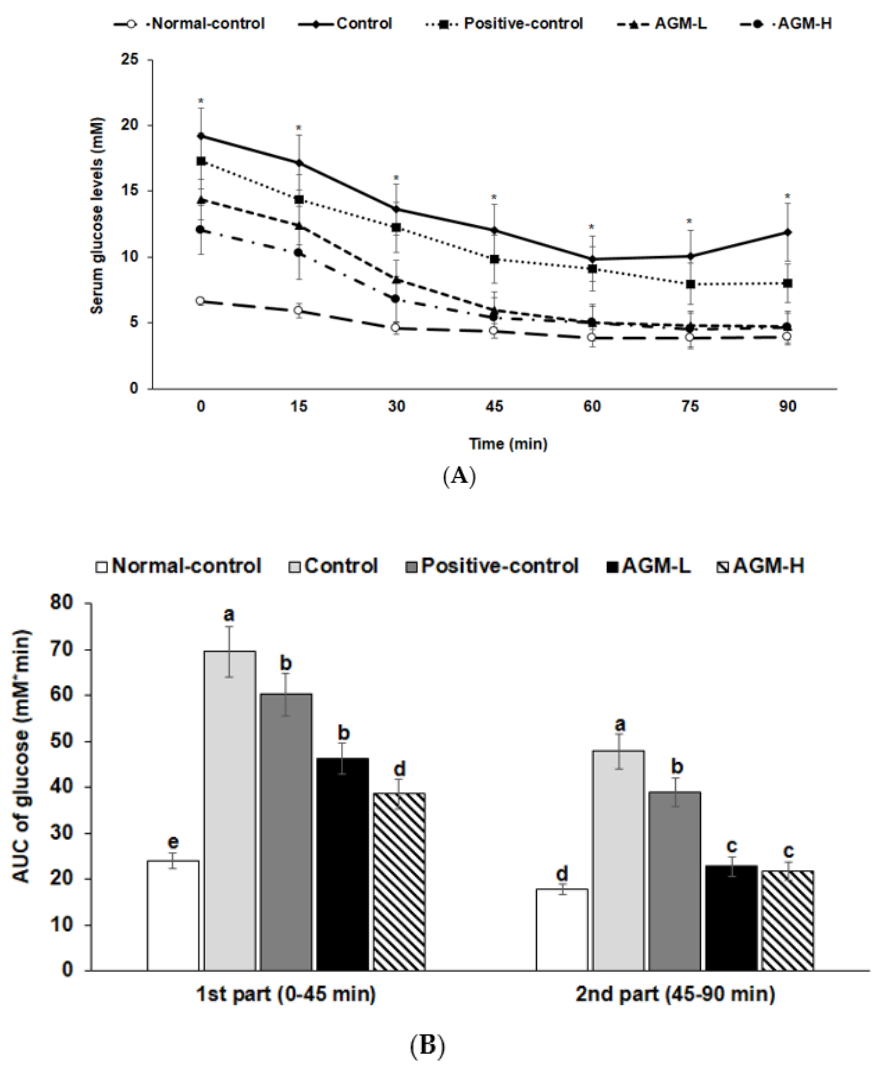
Figure 3. Changes of serum glucose concentrations during the intraperitoneal insulin tolerance test (IPITT). Px rats were fed a high fat diet supplemented with aronia, red ginseng, shiitake mushroom, and nattokinase powders (1) 0.5 g mixture/kg bw/day (AGM-L), (2) 1 g mixture/kg bw/day (AGM-H), (3) 1 g dextrin /kg bw/day (control), or (4) metformin (120 mg/kg body weight; positive-control) for 12 weeks. Sham rats fed the same diet of the control. IPITT was conducted with intraperitoneal injection of 0.75 IU insulin/kg body weight and measured serum glucose concentrations in blood collected from the tail every 15 min for 90 min. Changes of serum glucose levels were measured during IPITT ( A ). The average of the area under the curve (AUC) of glucose ( B ) during the first part (0–45 min) and second part (45–120 min) of IPITT. Each dot and bar and error bar represents the mean ± SD ( n = 10 of each group). * Significantly different among the groups at each time point at p < 0.05. a,b,c,d Different superscripts on the bars represent significant differences at p <